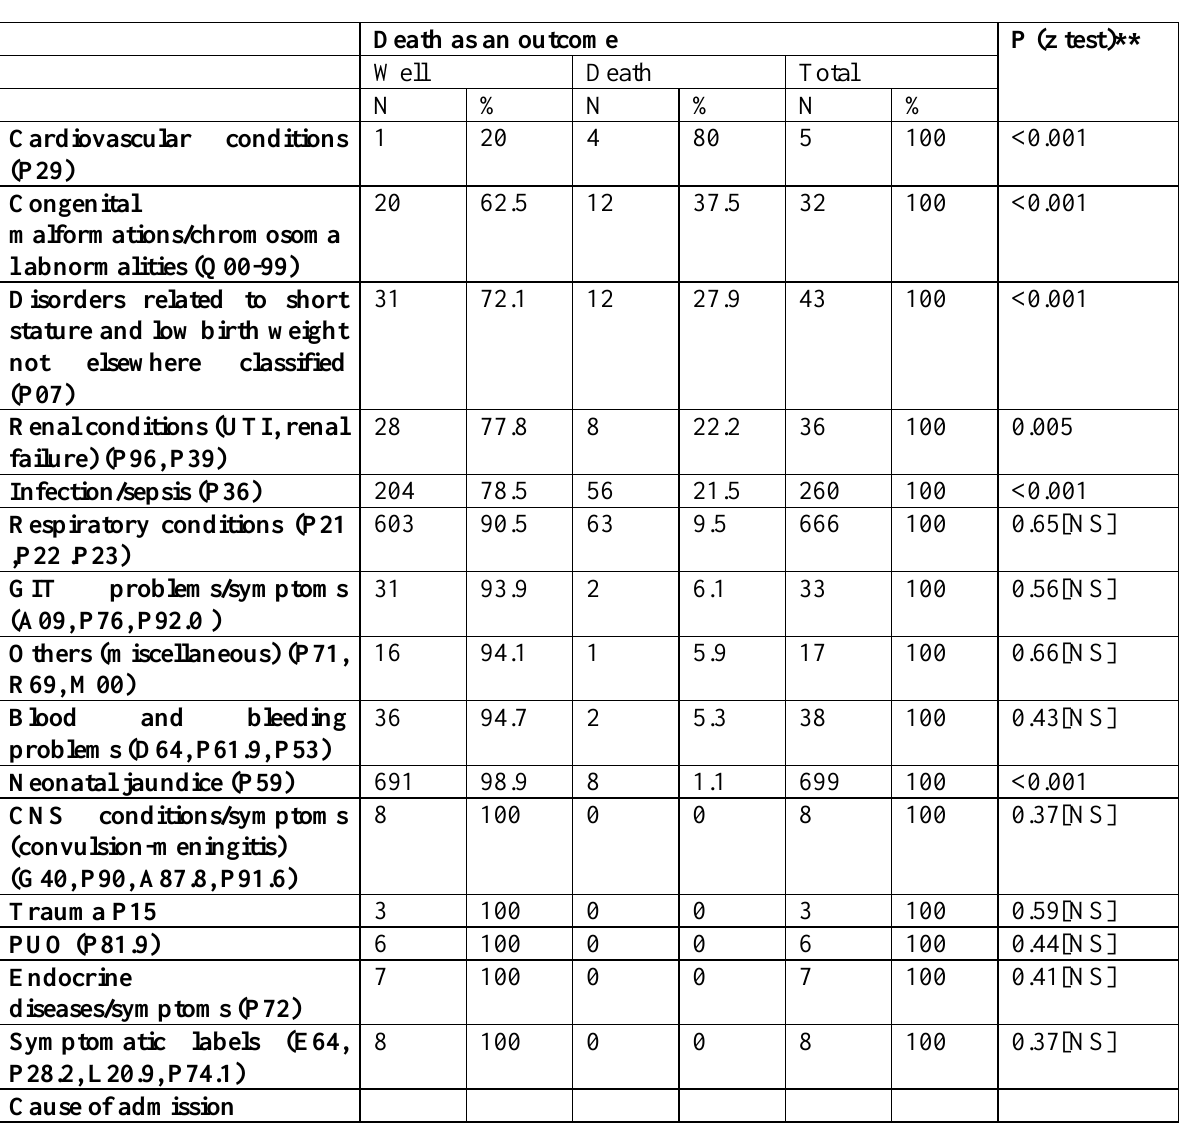
Table5: The relative frequency of death as an outcome by category of causes of admission. Case fatality rates according to causes of admission which reflect the risk of dying depended on causes of admission arranged from high risk to low , P (z test) for difference between the proportion dying in a specific cause of death and a hypothesized proportion of 9% (the overall proportion dying in the total